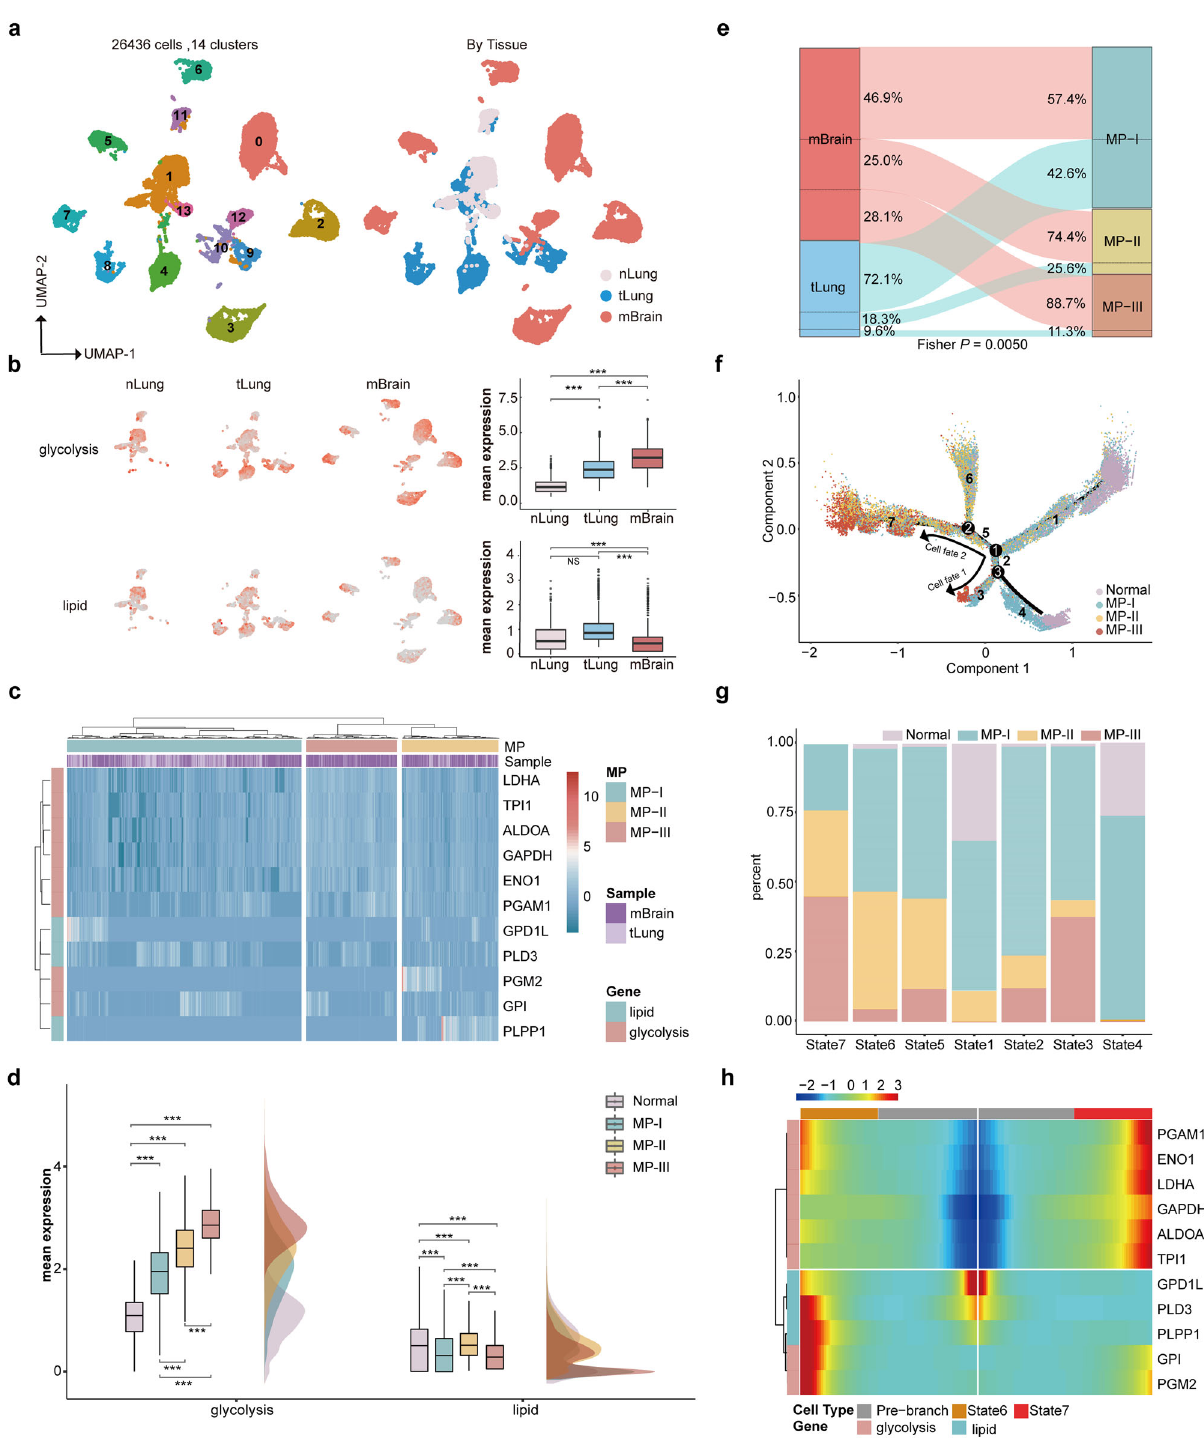
Fig. 5 Cell trajectory and branched expression analyses for the MPs in the single-cell RNA-sequencing dataset. a UMAP plot of 26,436 epithelial tumor cells colored based on the major cell lineages and normal, tLung, and mBrain tissues in the GSE131907 dataset. b Average expression of the eight glycolytic and three lipid metabolic genes within normal, tLung, and mBrain tissues represented by UMAP plots and box plots. c Hierarchical clustering heatmap for epithelial tumor cells based on the mRNA expression ( Z -score) of the 11 metabolic genes. d Raincloud plot for the average expression of glycolytic and lipid metabolic genes in the three MPs and normal cells. e Sankey diagram showing the fl ow/change of tumor tissues (tLung/mBrain) in the MPs. f Unsupervised transcriptional trajectory of epithelial cells based on the 11 metabolic genes using Monocle (version 2), colored based on MP-I, -II, -III, and normal. g Relative percentages of the MP populations for each cell state as shown in trajectory. h The mRNA expression ( Z -score) heatmap for the 11 metabolic genes in a branch-dependent manner. Genes (rows) are clustered and cells (columns) are ordered according to the pseudotime development, which along the pre-branch to State 6 and State 7. Boxplots extend from the 25th to 75th percentiles, the line indicates the median, and whiskers indicate the